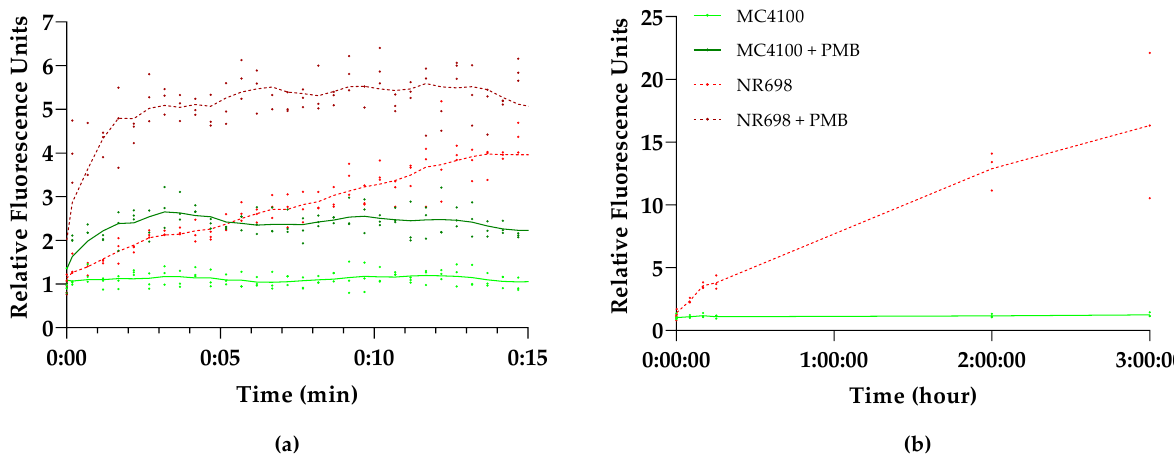
Figure 2. E. coli outer membrane (OM) integrity affects UnaG fluorescence. Kinetics of UnaG fluorescence in E. coli wild-type (WT) strain MC4100 (solid shades of green) and the isogenic E. coli OM-defective mutant NR698 (dashed shades of red) after ( a ) 15 min exposure of 10 µ g/mL PMB and subsequent addition of 5 µ M BR (dark shades) or 5 µ M BR only (light shades); ( b ) 3 h exposure of 5 µ M BR only. The data points represent three independent measurements normalized to the negative control of MC4100 in the presence of BR only. The mean is represented by the line of the same color. The results indicate that the OM indeed excludes BR from entering the cells as